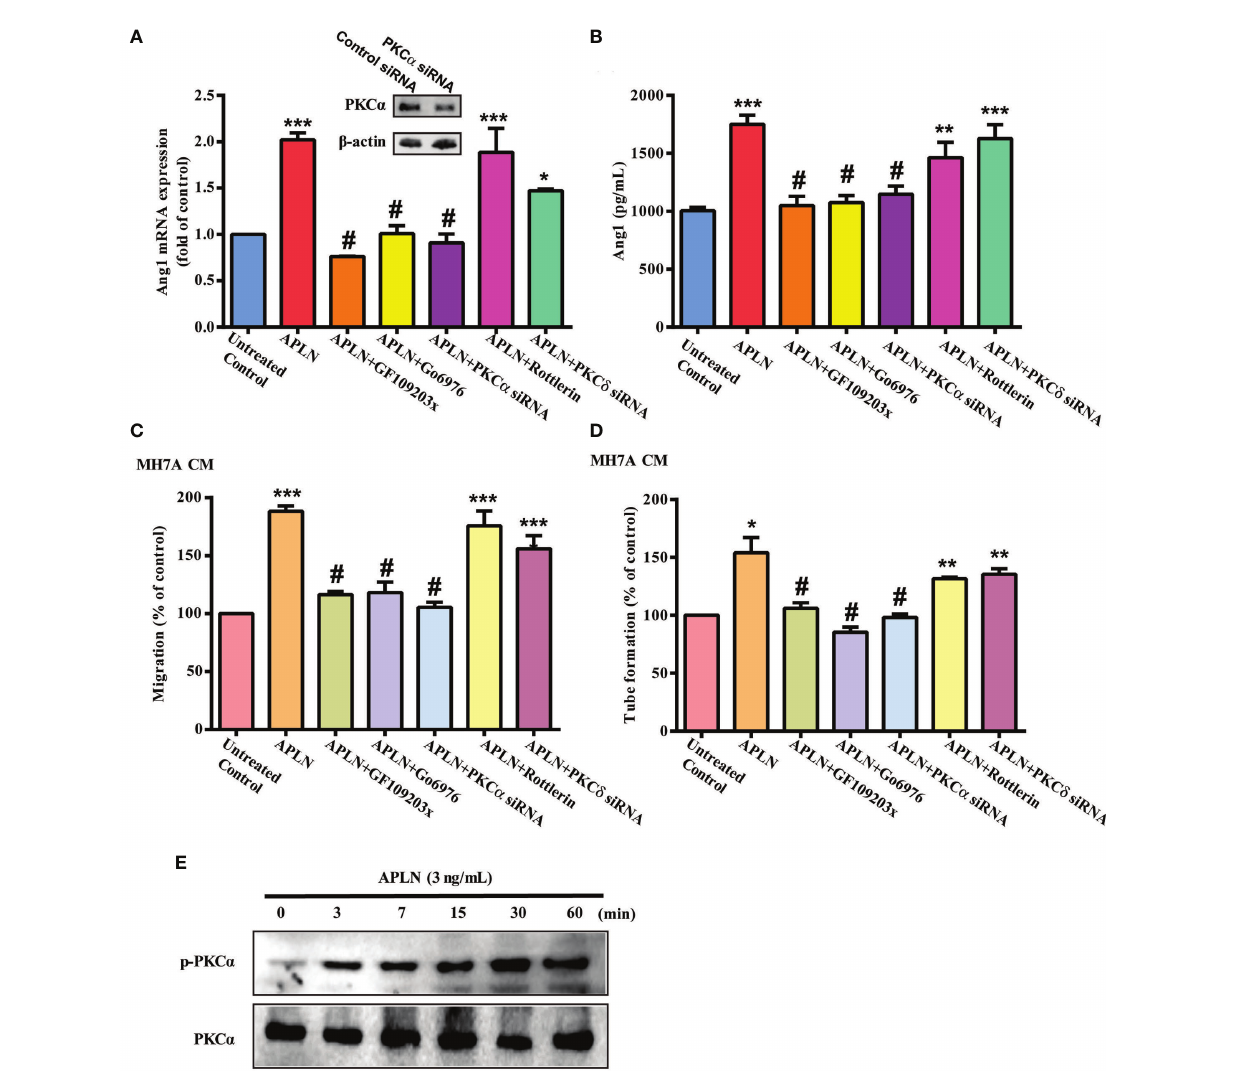
FIGURE 3 | PKC a signaling regulates APLN-induced effects on Ang1 expression and EPC angiogenesis. (A, B) RASFs were pretreated with GF109203X and Go6976 for 30 min, or transfected with PKC a and PKC d siRNAs for 24 h, then stimulated with APLN for 24 h. Ang1 expression was examined by qPCR and ELISA assays. (C, D) Collected CM was applied to EPCs, and EPC angiogenesis was determined. (E) RASFs were treated with APLN time-manner and Western blot (n=3) determined PKC a phosphorylation. * p < 0.05, ** p < 0.01 and *** p < 0.001 versus the control group; # p < 0.05 versus the APLN-treated